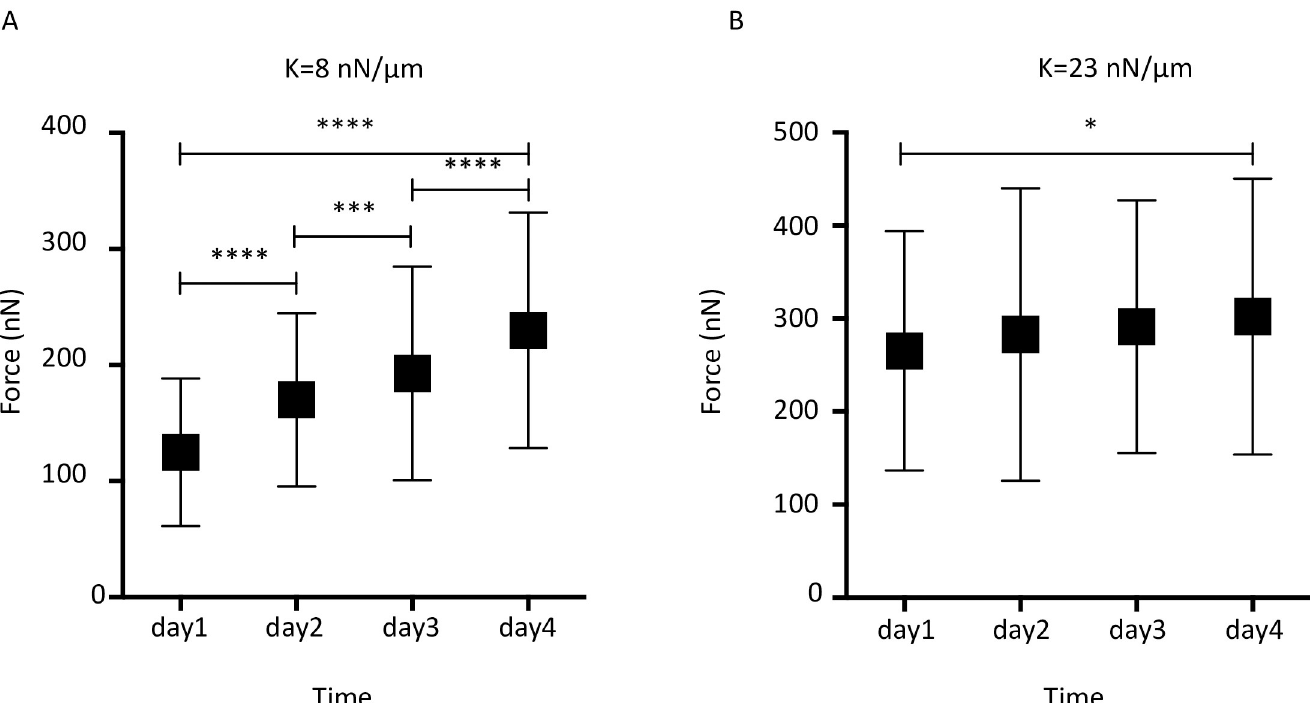
Fig 5. Monitoring of the detected forces induced by spheroid growth during four days. Forces detected using (A) microdevices with a pillar diameter = 28 μ m and K = 8 nN/ μ m (n = 12, 16, 21, and 20 microdevices from day 1 to day 4), and (B) microdevices with pillar diameter = 36 μ m and K = 23 nN/ μ m (n = 8, 13, 10, and 12 microdevices from day 1 to day 4). Comparisons between days were performed using the two-tailed Student’s t test, 95% interval confidence: � = P < 0.05, ��� = P < 0.001, ���� = P < 0.0001. Values are the mean ± standard